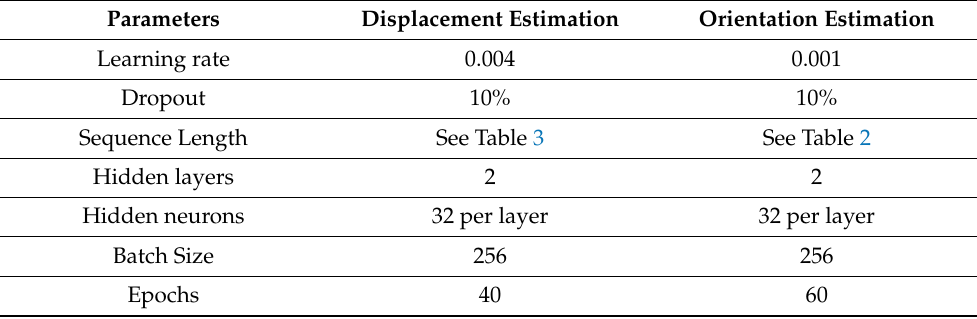
Table 7. Training parameters for the